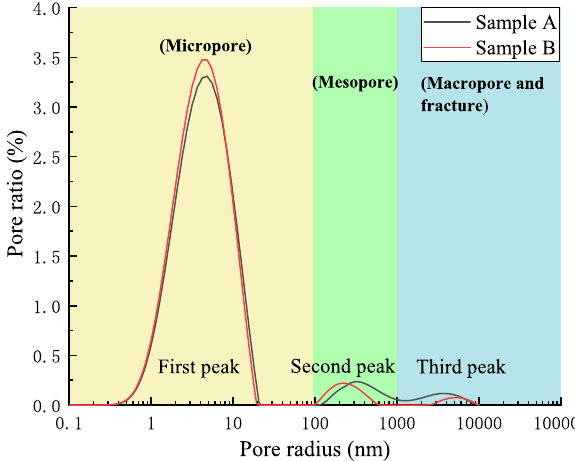
Figure 7. Pore radius distribution of coal sample.